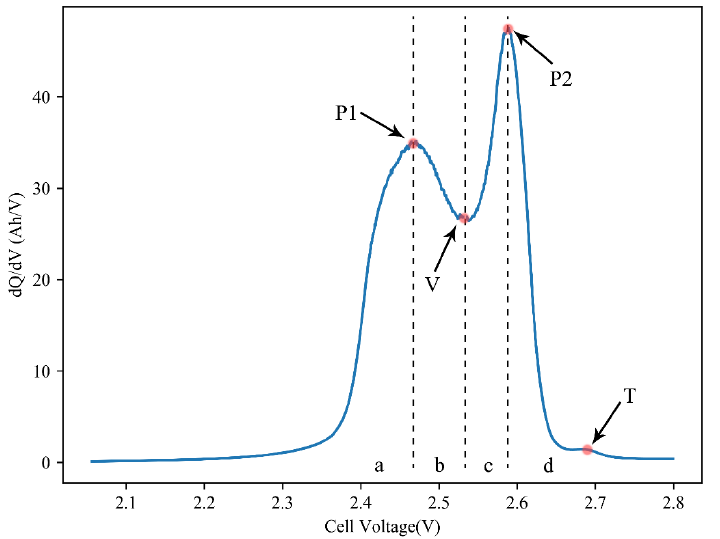
Figure 6. Typical IC curve of LTO/LMO cell.